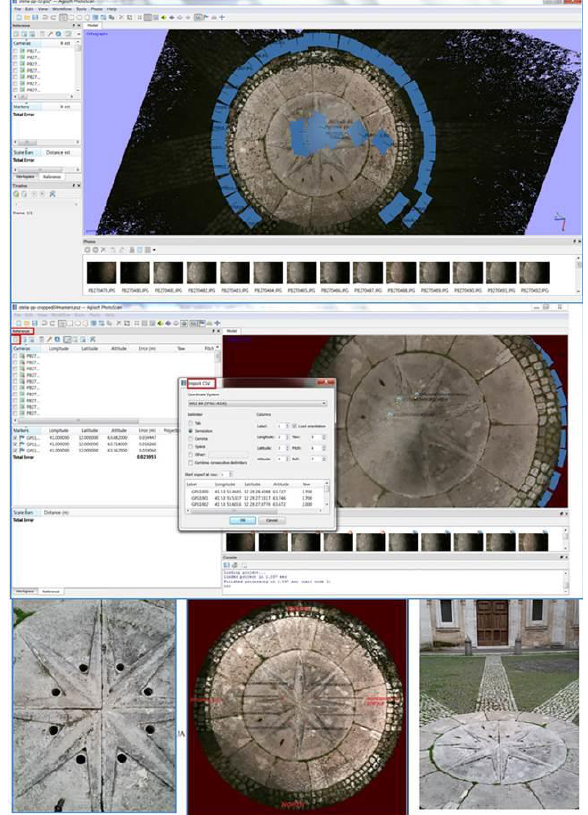
Figure 10. Chigi emblem: dense stereo matching elaboration The star, sculpted in a travertino marble disk of 1.85 m in diameter, surrounded by a circular flat band of 60 cm, is divided in quarters lightly sloping toward the centre, aligned to the longitudinal East West axis of the building. It has been